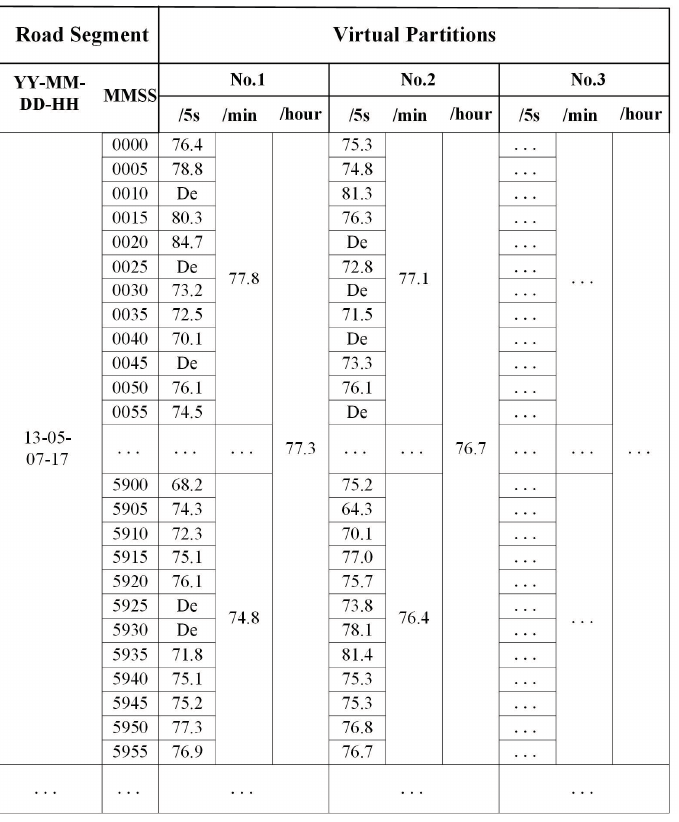
Figure 5. An example noise estimation for virtual partitions on road segment 15 in two periods of interest: one minute and one hour.